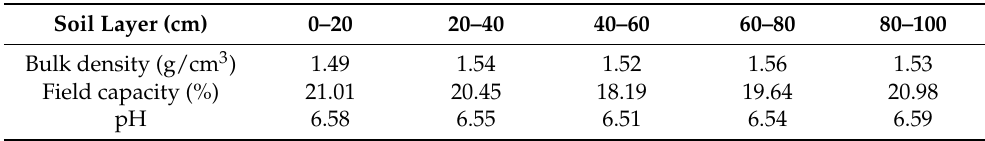
Table 1. The soil bulk density, field capacity and pH of the soil in the 0–100 cm soil layer in the experimental plots.